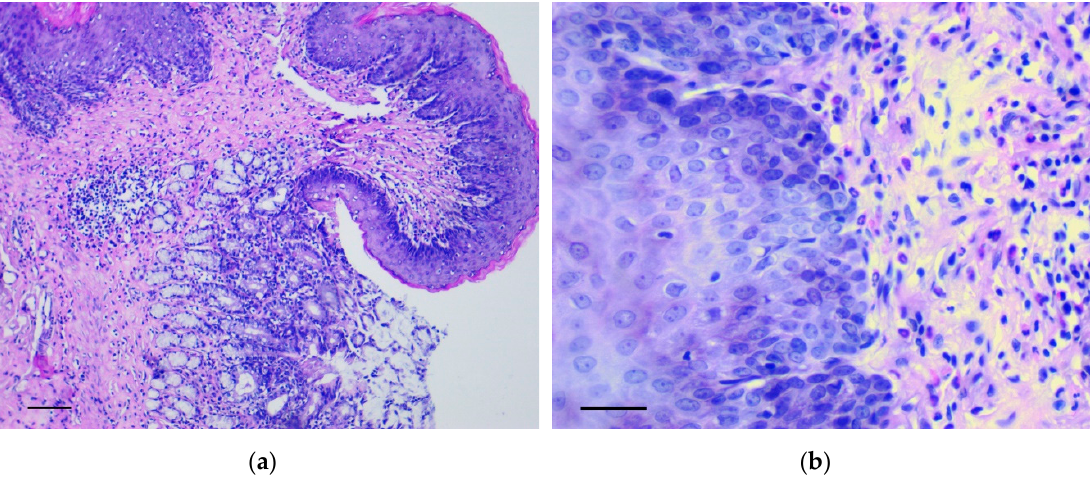
Figure 1. The pathological changes in the forestomach. ( a ) Area of the groove between the forestomach and glandular stomach. Mayer’s hematoxylin and eosin (H&E) staining, scale bar 200 µm; ( b ) Increasing thickness and number of epidermal rows in the basal and spinous layers of forestomach. H&E staining, scale bar 100 µm.